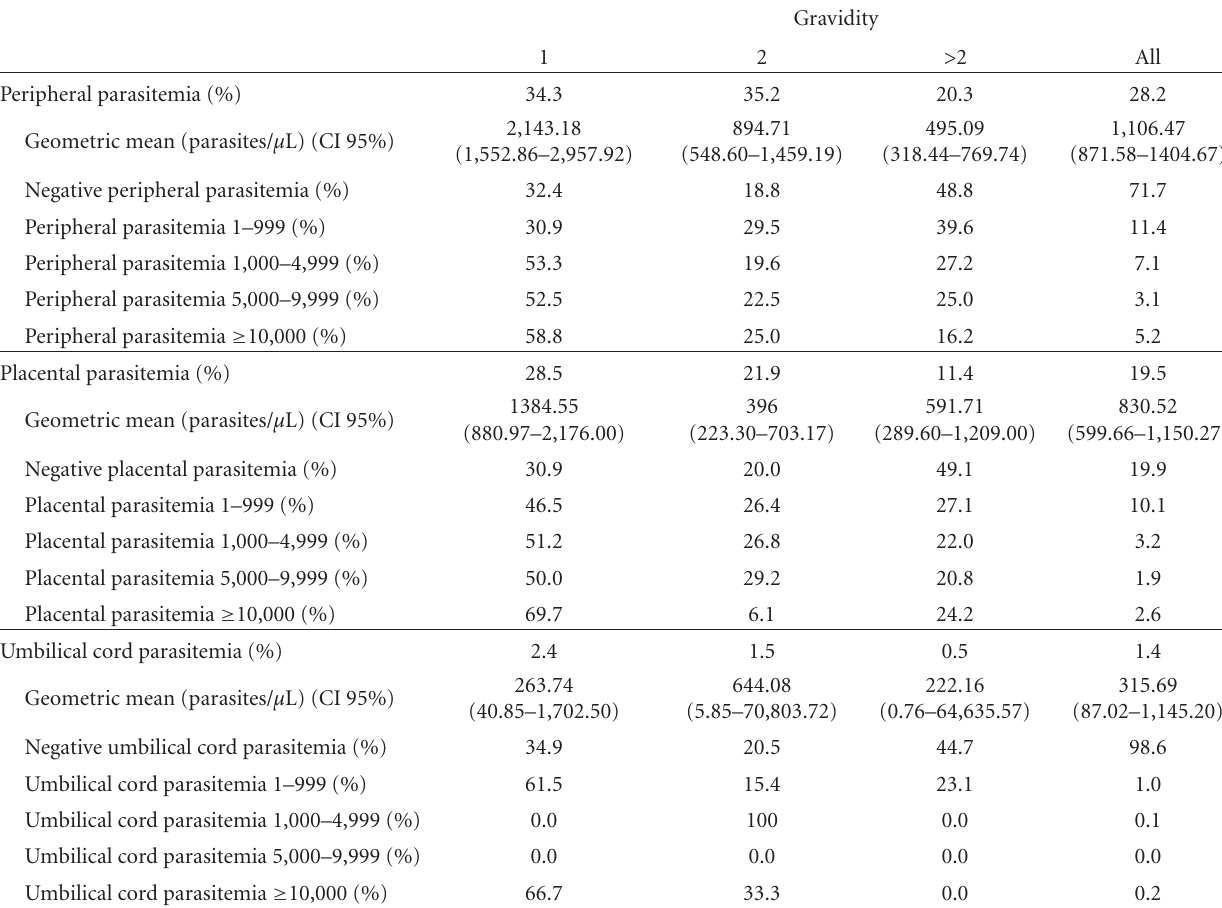
Table 2: The proportion of newborns with Plasmodium falciparum parasitemia in umbilical cord blood, placental parasitemia, and maternal parasitemia, along with parasite